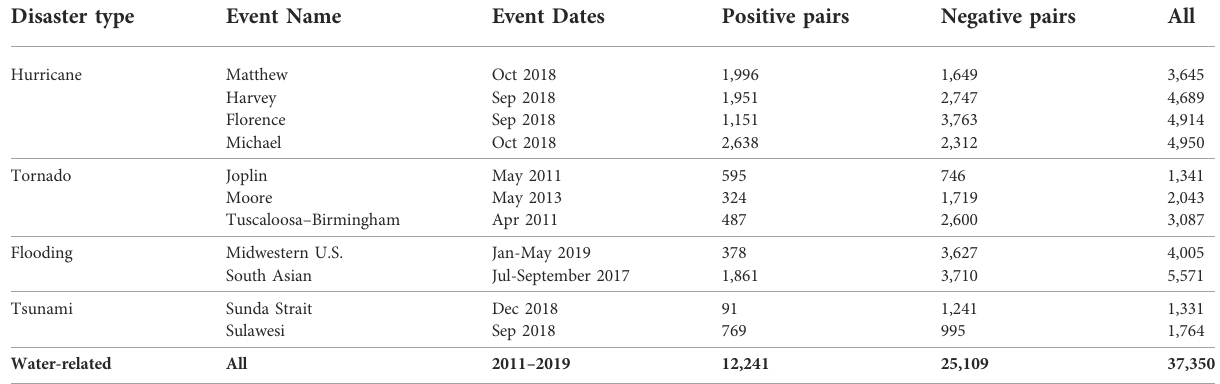
TABLE 1 Statistics of dataset with 11 events.